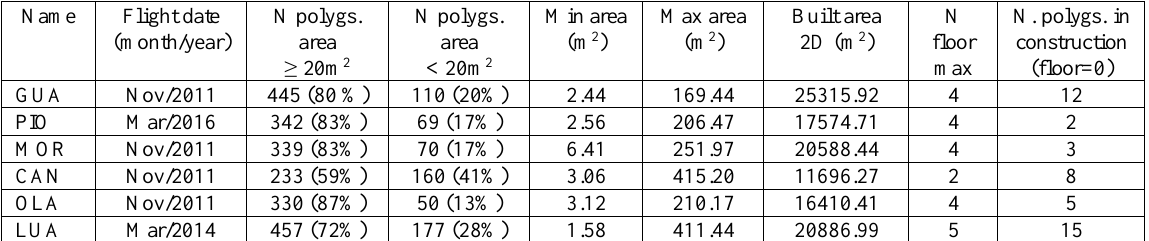
Table 2. Characteristics of the reference data for favela ’s buildings